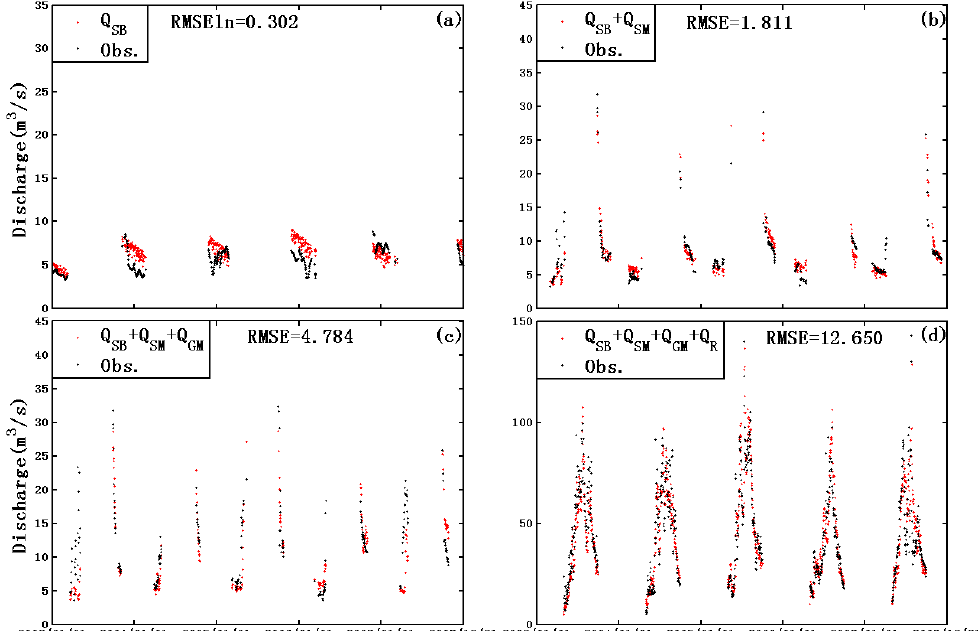
Figure 7. Stepwise calibration of grouped parameters on partitioning curves. (a) Partitioning curves after calibrating K A and K D on Q SB . (b) Partitioning curves after calibrating D s on Q SB + Q SM . (c) Partitioning curves after calibrating D g on Q SB + Q SM + Q GM . (d) Partitioning curves after calibrating W M and B on Q SB + Q SM + Q GM + Q R . The goodness of fit between observed and simulated discharge is measured by RMSEln (for the Q SB part) or RMSE (for other parts).